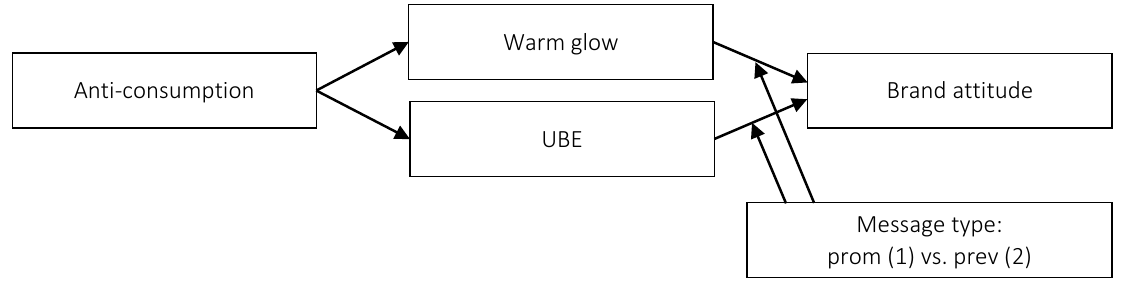
Figure 1. Research